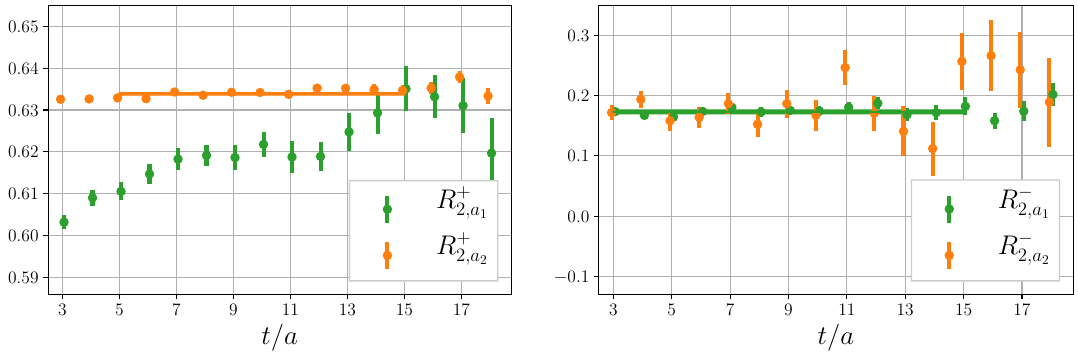
Figure 4 . The ratios R + and R − (for the pion) defined in eqs. (2.12) as functions of the 2 ,a i 2 ,a i lattice time t with momentum p = (1 , 1 , 1) ℘ for the ensemble N203 ( a = 0 . 064 fm). Clearly, for the extraction of R + (left), the ratio R + is to be preferred to R + , which suffers considerably from 2 2 ,a 2 2 ,a 1 (right) neither data set excited state effects and carries larger statistical errors. For the case of R − 2 are seems to indicate any significant excited state contribution, but the statistical errors of R − 2 ,a 1 much smaller. The bands indicate the fit ranges and